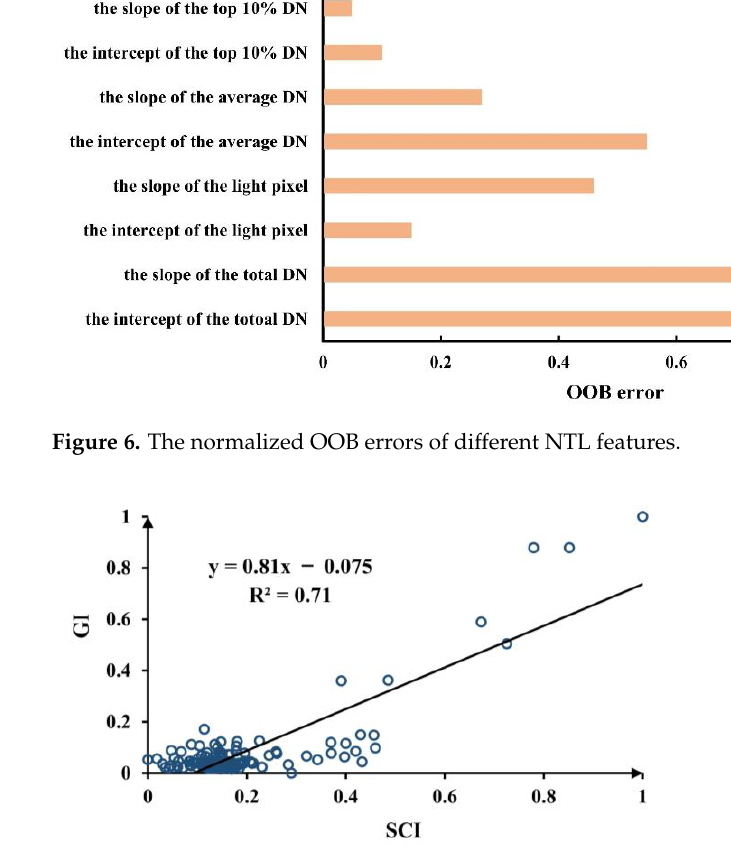
Figure 7. Scatter plot of the GI and SCI, where the black line indicates the best fitting line.